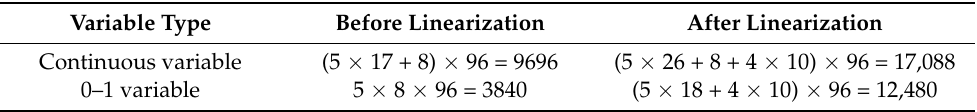
Table 1. Statistical table of variables before and after linearization of a robust optimization